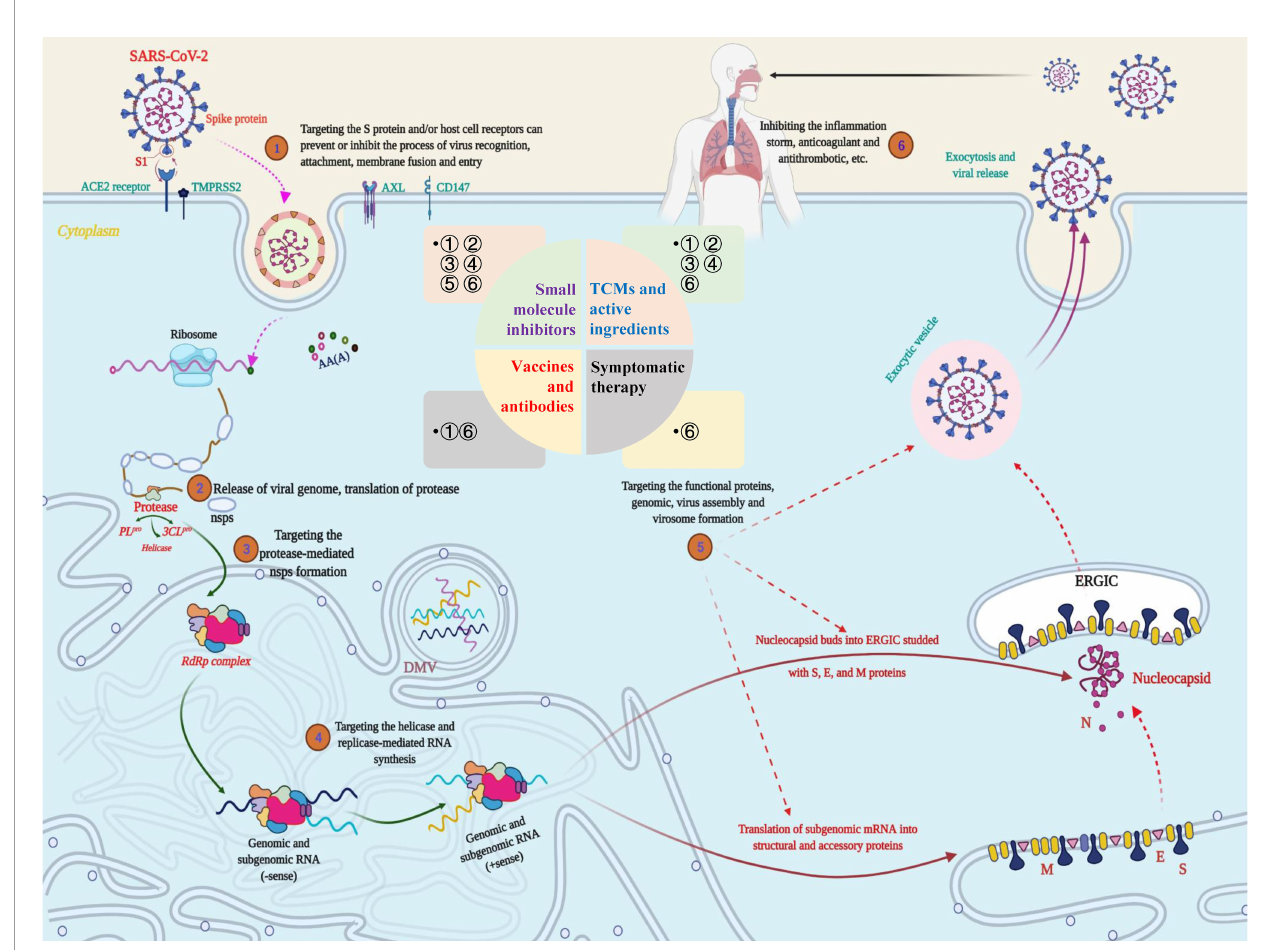
FIGURE 4 | Potential targets and targeted therapeutic strategies for combating SARS-CoV-2-induced COVID-19. Scheme of the potential targets, intervention strategies and types of therapeutic drugs in the cycle of SARS-CoV-2 infection, replication, and transmission. During the infection stage, SARS-CoV-2 recognizes and interacts with host cell surface receptors through the spike (S) protein or transmembrane glycoprotein CD147 and enters the host cell through membrane fusion and endocytosis. After the virus enters the host cell, SARS-CoV-2 releases its nucleocapsid and genome into the cytoplasm and translates a large number of nonstructural proteins (nsps) including coding RNA-dependent RNA polymerase (RdRP), papain-like protease (PL pro ) and 3C-like protease (3CL pro ). Under the action of these enzymes, a full-length negative antisense genome template is synthesized to produce the new RNA genome and assembled to form virus particles, which are then released into the extracellular space through exocytosis. Uncontrolled replication promotes SARS-CoV-2 infection, leading to immune disorders and in fl ammatory cytokine storms and ultimately leading to damage to multiple organs, especially the lungs. The whole process exposed multiple potential targets, providing important guidance for research on anti-SARS-CoV-2 targets, drugs and treatment